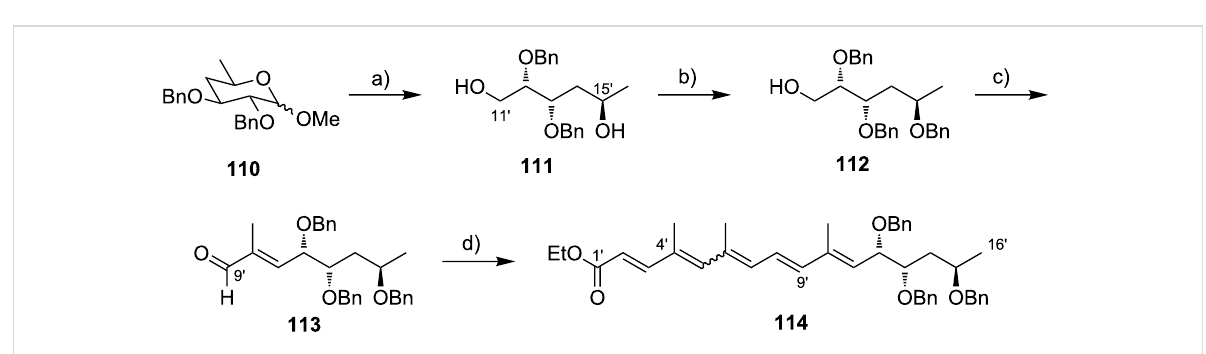
Scheme 13: Gurjar and Cherian’s synthesis of the benzyl-protected mycolactone A/B pentaenoate side chain. Reagents and conditions: a) (i) H 2 SO 4 , dioxane/water 2:1, 100 °C; (ii) NaBH 4 , MeOH, 0 °C, 54% (2 steps); b) (i) TBSCl, imidazole, CH 2 Cl 2 , rt; (ii) BnBr, NaH, DMF, rt; (iii) TBAF, THF, rt, 75% (3 steps); c) (i) (COCl) 2 , DMSO, Et 3 N, − 78 °C; (ii) Ph 3 P=C(Me)COOEt, benzene, reflux, 80%; (iii) DIBAL-H, CH 2 Cl 2 , − 78 °C, 94%; (iv) MnO 2 , CHCl 3 , rt; d) 109 , LDA, THF, − 78 °C to 0 °C, 65% ( Z - Δ 4’,5’ / E - Δ 4’,5’